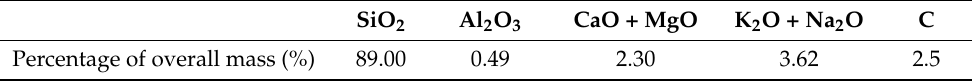
Table 2. Chemical composition of micro-silica as declared by the manufacturer.